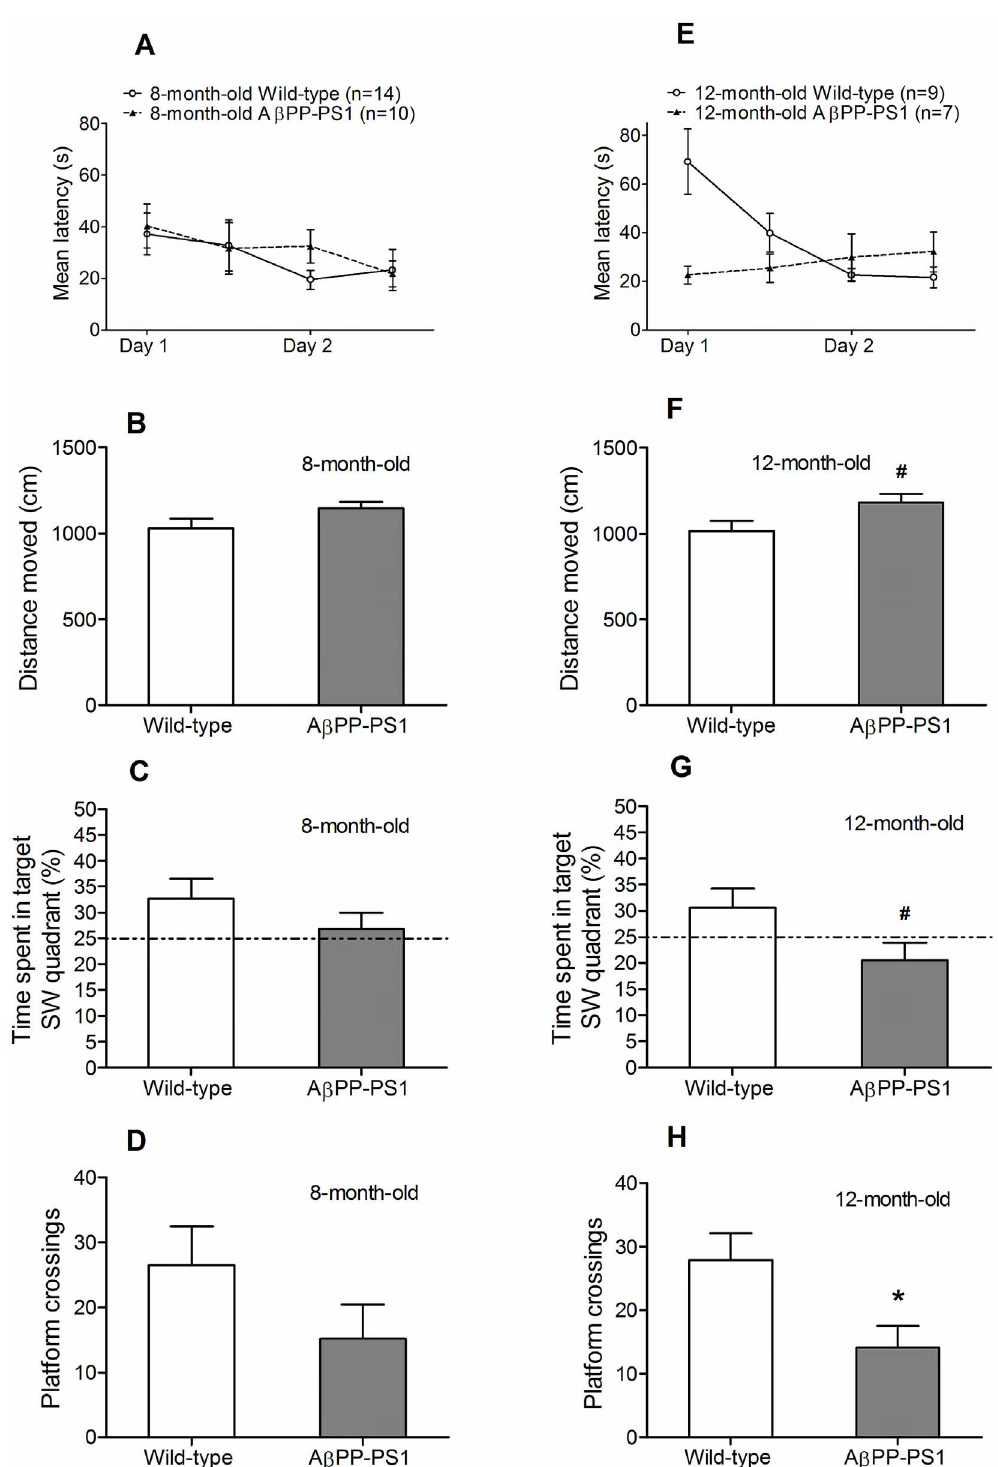
Figure 7. Reverse Morris water maze learning and memory in 8- and 12-month-old wild-type and A b PP-PS1 mice. Spatial learning with an extra episodic memory component was measured in a 2-day acquisition phase, by determining the latency to find a hidden platform in the SW quadrant. Spatial memory was tested in the probe phase in which the percentage of time spent in the target SW quadrant was measured and the total number of platform crossings (where formerly the platform had been located). A: Both 8-month-old wild-type (n=14) and A b PP-PS1 mice (n=10) showed a decrease in latency during training. Overall latencies did not differ between the genotypes. B: During the probe trial, the 8-month- old wild-type and A b PP-PS1 mice traveled a similar distance. C: No differences were observed between the 8-month-old mice in the percentage of time spent in the target SW quadrant, although only wild-type mice deviated from 25% chance performance level. D: No differences were observed between the 8-month-old mice in the frequency of platform crossings E: Only 12-month-old wild-type mice (n=9) showed a decrease in latency